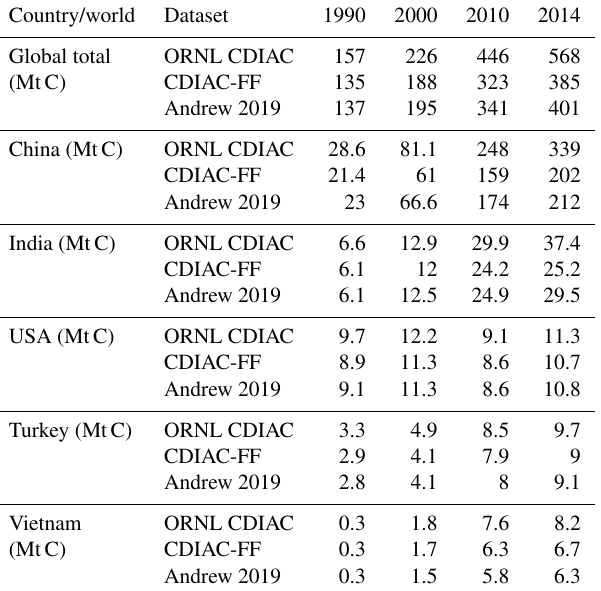
Table 3. Comparison of estimates of CO 2 emissions from cement manufacture for the globe and the top five cement-producing coun- tries. Data are from the most recent CDIAC-FF update, the last ORNL CDIAC inventory update, and an independent inventory pro- duced by Andrew